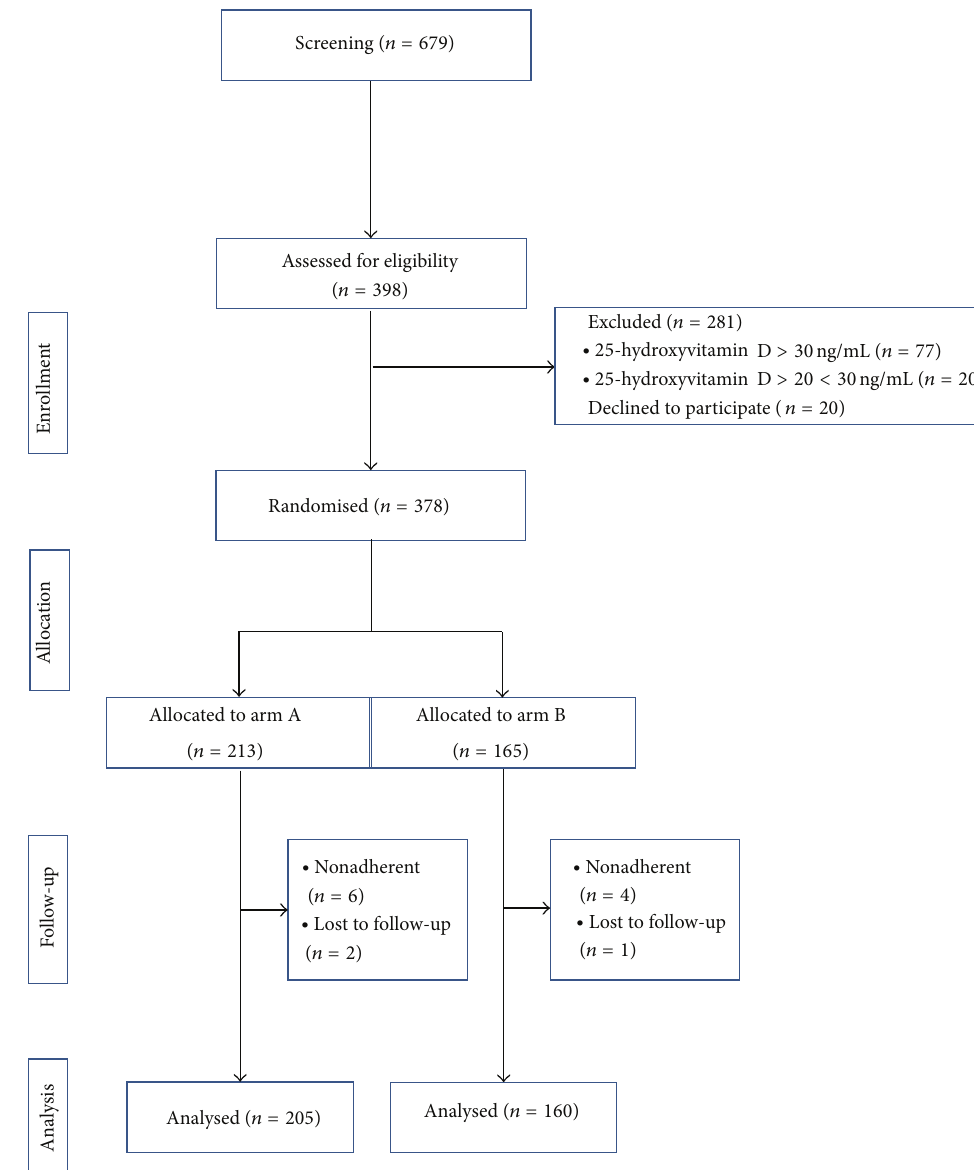
Figure 1: Summary of patient flow diagram. Individuals with 25(OH)D deficiency. Patients in the Arm A group received 400I.U. of vitamin D3 daily during the study, whereas patients in the Arm B group worked to improve factors that influence 25(OH)D status but did not receive vitamin D3